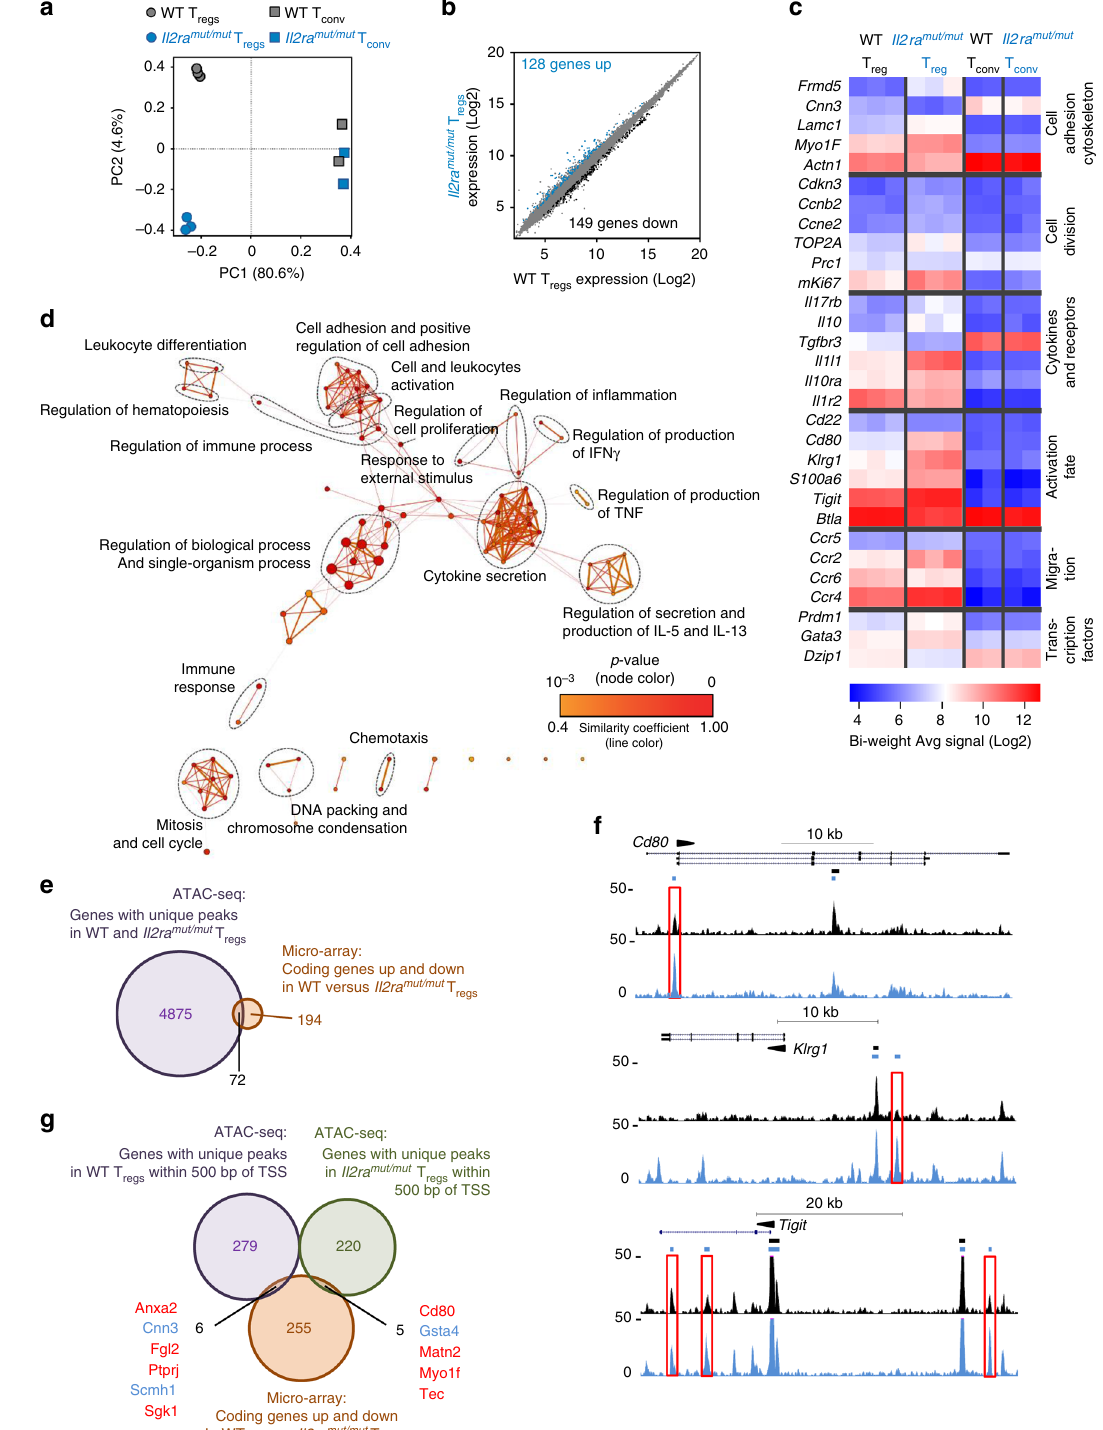
among which 26 are common to Il2ra mut/mut T reg cells despite additional regions (2929) in Il2ra mut/mut thymocytes, showing that ectopic binding of this pioneer factor occurs when IL-2 different SATB1-bound areas (Fig. 5d and Supplementary signals are limiting (Fig. 5a). Interestingly, the 123 unique Data 7). Interestingly, 29 of the 96 genes with unique SATB1- SATB1-binding regions in WT thymocytes localize closer to binding sites are located within less than 2 kb from the TSS, and a promoter areas compared to that of Il2ra mut/mut counterparts majority encodes for DNA remodeling proteins, cell cycle, signal transduction and metabolism (Supplementary Fig. 5c). These which are far from TSS (>100 kb) in distal intergenic regions genes exhibit variable levels of expression across thymocyte (Fig. 5b, c and Supplementary Fig. 5b). Assigning the 123 SATB1- development 41 , in particular between the SP CD4 + thymocyte bound regions to the nearest gene TSS highlighted 96 genes NATURE COMMUNICATIONS| (2018) 9:5368